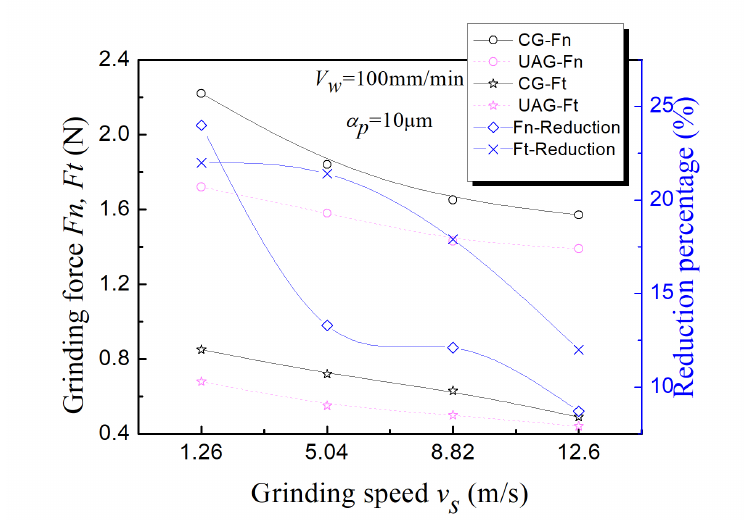
Figure 6. Side grinding: the influence of grinding speed changes on the grinding force.